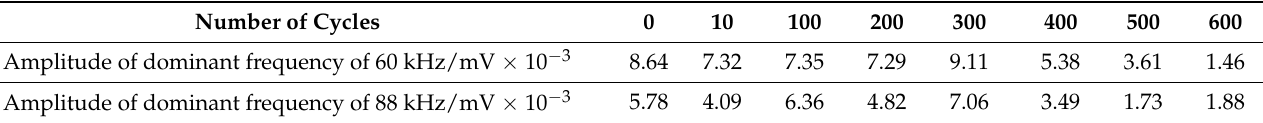
Table 5. Amplitude information of acoustic emission signals of Group A batteries during discharge. Number of Cycles 0 10 100 200